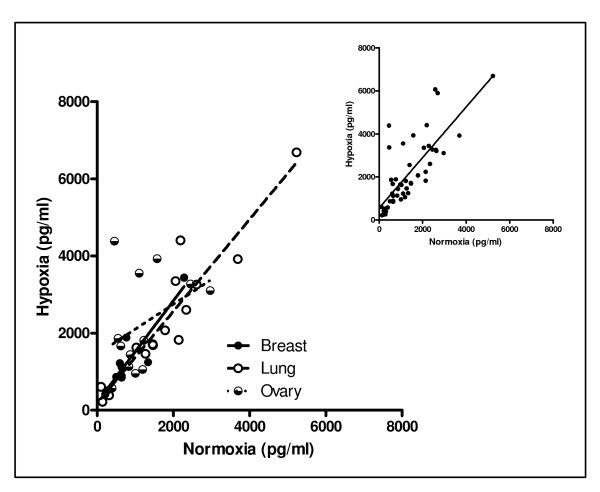
Linear correlations between normoxic and hypoxic conditions exist for VEGF and group by tumor type. Fifty cell sources (45 primary tumor cultures and 5 immortalized cell lines) were evaluated for VEGF expression measured by ELISA-based assay. Linear correlations exist between cells grown in normoxic and hypoxic conditions (Table 2). The larger graph divides the specimens by tumor type, while the inset combines all data sets.